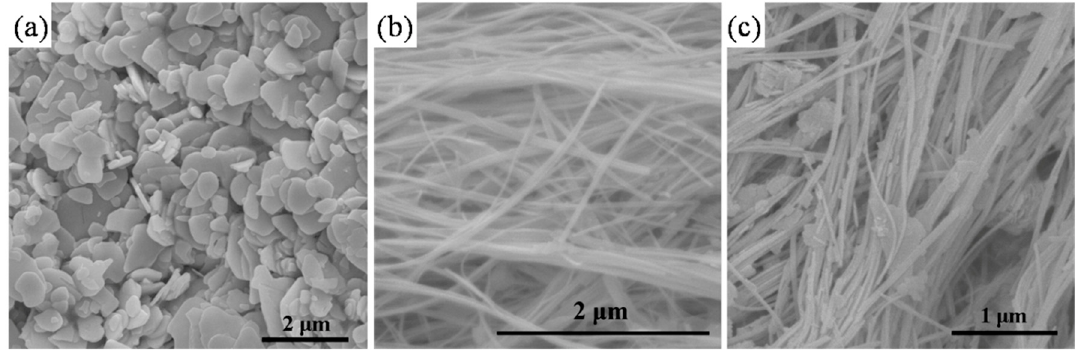
Figure 2. SEM images of C-BCO ( a ), BCO ( b ), and Ca-BCO nanowires ( c ).